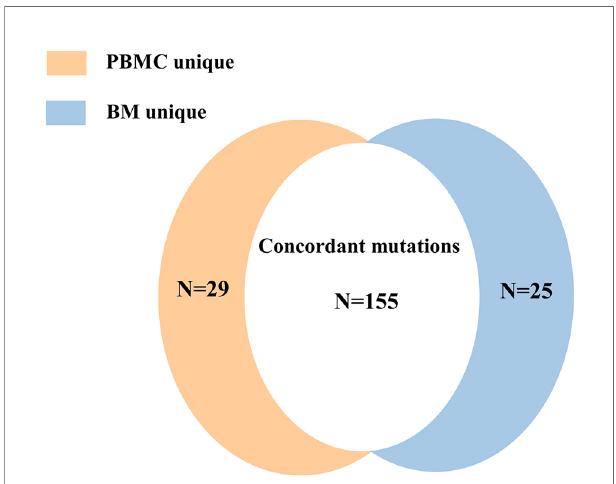
FIGURE 6 | The concordance of the number of mutation detected in BM and